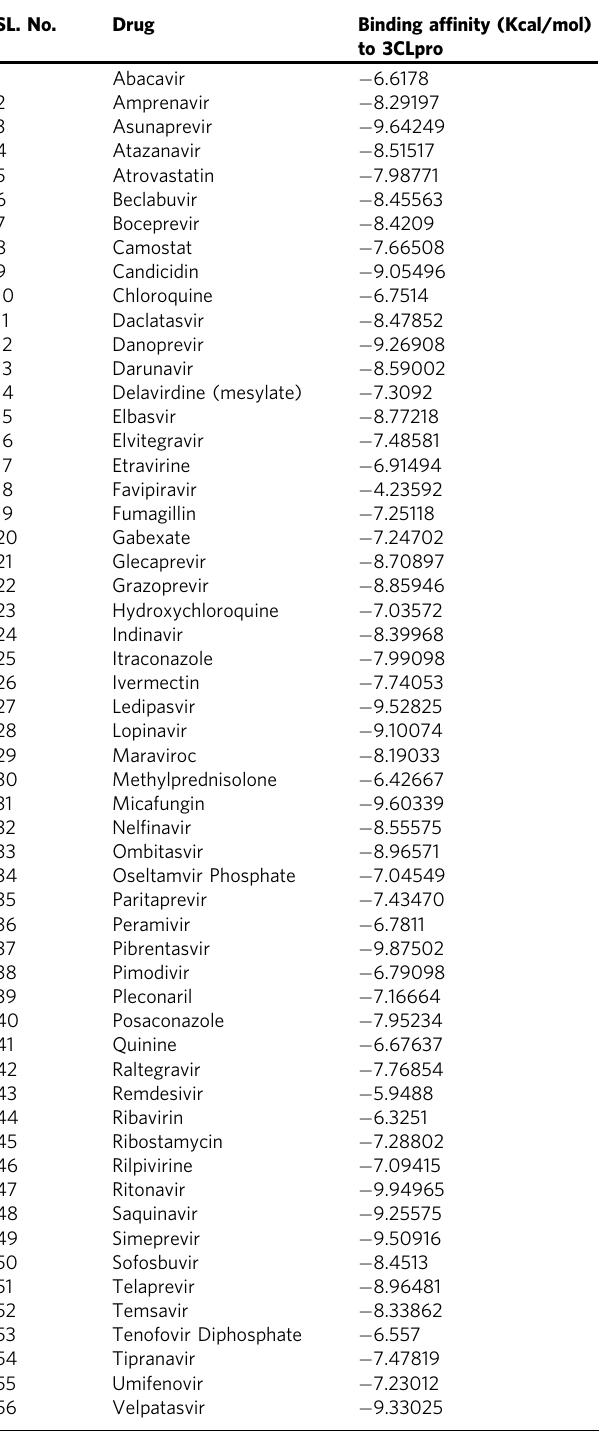
Table 1 List of all the drugs with highest S score for 3CL protease calculated by computational studies (S